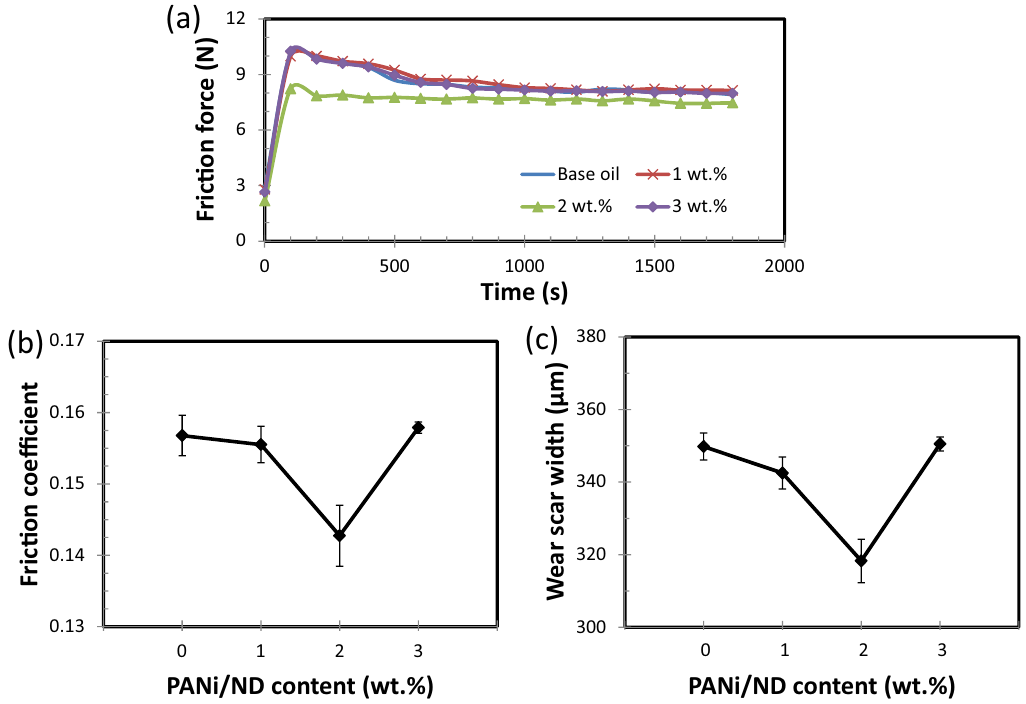
Figure 6: The friction force and corresponding friction coe ffi cient as well as wear loss of the block - on - ring tests lubricated with di ff erent nanolubricant additives content: ( a ) friction force vs time curves, ( b ) variation of friction coe ffi cient in stable wear stage and ( c ) variation of wear loss for block